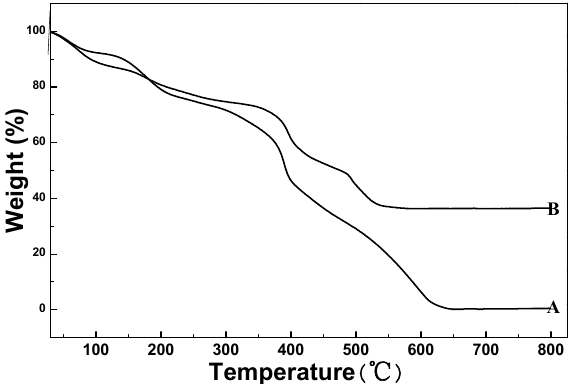
Figure 2. Thermogravimetric analysis (TGA) curves of pure MF sphere template A , and the as-dried core–shell structured spheres of MF@C-TiO 2 B .